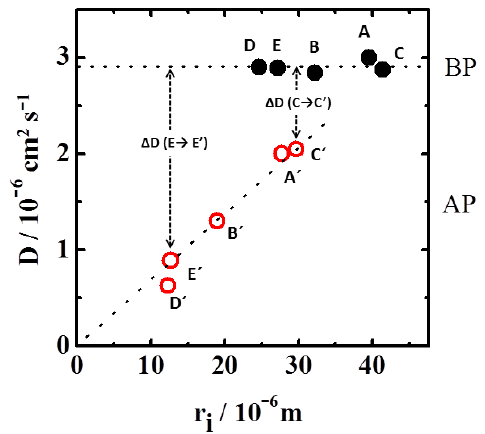
Figure 4. Diffusion coefficient against the particle size before (●) and after ( ○ ) plasma application. Dotted lower straight line corresponds to the linear fitting of the experimental data. r i represents the particle radius at the beginning of the swelling process.